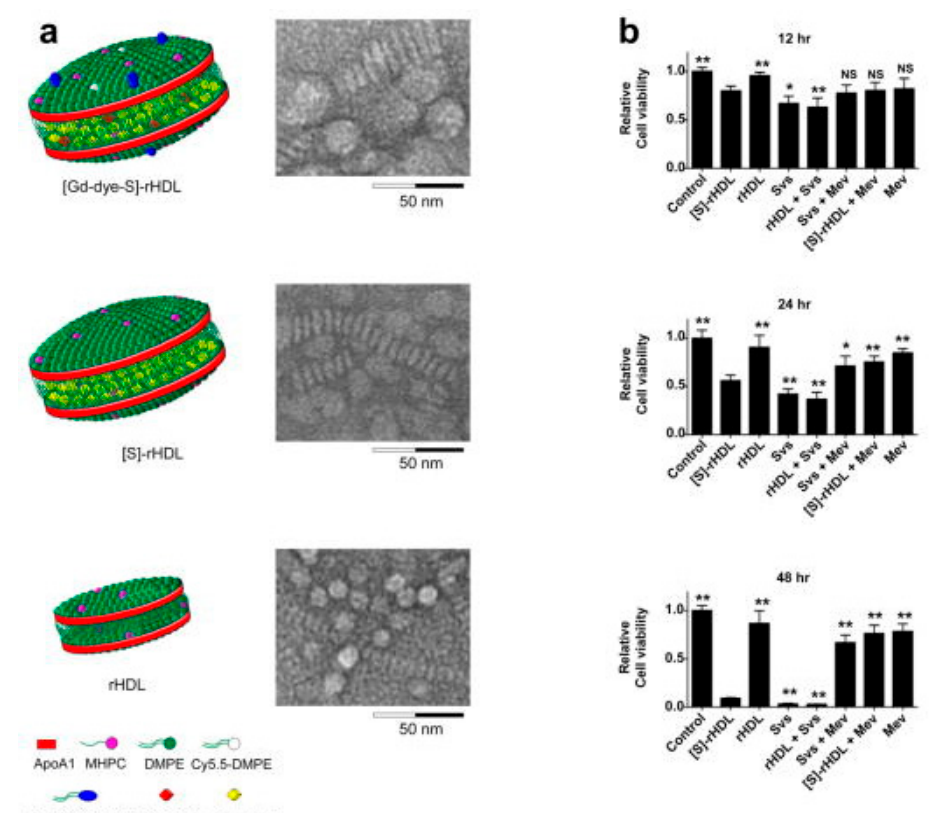
Figure 1. Schematic representations of nanoparticle formulations and in vitro efficacy data. ( a ) Schematic representation of dual gadolinium and fluorescent dye (Cy5.5, DiO, DiR) labeled statin containing reconstituted high density lipoprotein ([Gd-dye-S]-rHDL), statin containing rHDL ([S]-rHDL), and rHDL. ( b ) In vitro cell viability assays of murine macrophages (J774A.1), incubated with combinations of [S]-rHDL (10 µ M statin) free simvastatin (10 µ M), rHDL plus free statin (10 µ M), free statin (10 µ M) plus mevalonate (100 µ M), [S]-rHDL (10 µ M) plus mevalonate (100 µ M), and only mevalonate (100 µ M). There was also a control group of cells not incubated with anything. Macrophage cell viability was markedly decreased in the [S]-rHDL and free statin group. This effect was abolished by the addition of mevalonate, indicating that the effect of HMGR inhibition on cell viability is mediated through the mevalonate pathway. N = 6 for all bars. * p < 0.05, ** p < 0.01. Reprinted from Nature communications. Duivenvoorden, R., et al., A statin-loaded reconstituted high-density lipoprotein nanoparticle inhibits atherosclerotic plaque inflammation, pages 3065. Copyright 2014